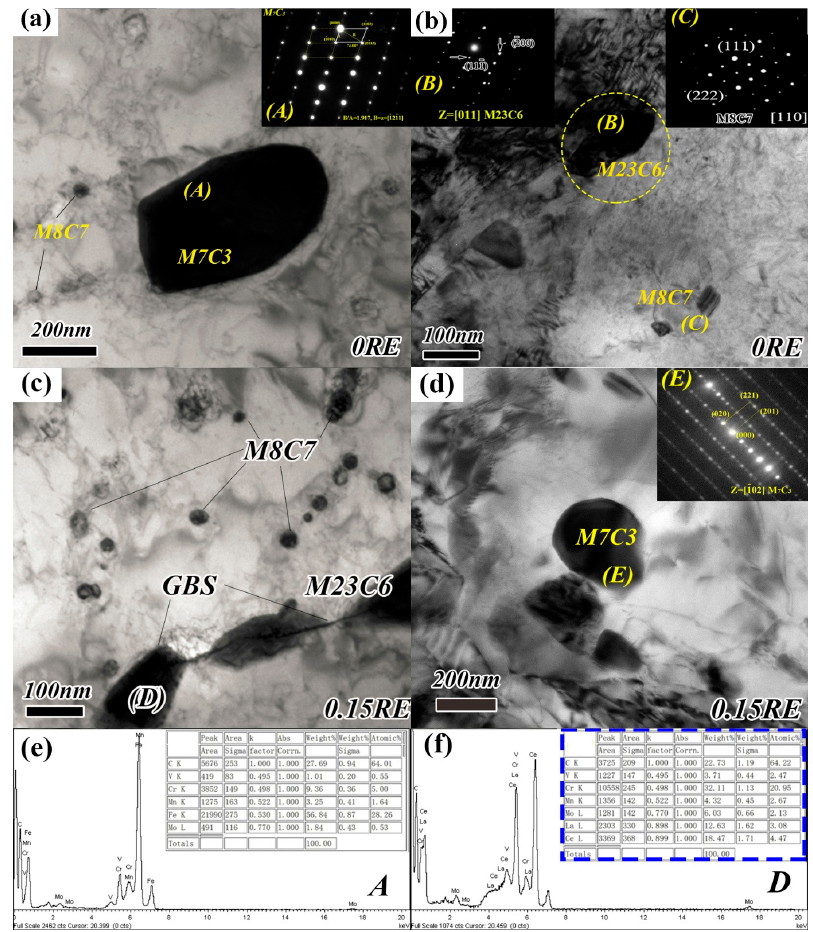
Figure 7. TEM microstructure with EDS analysis and diffraction pattern analysis of the types of carbides in the 4Cr5MoSiV1-RE die steel in 0RE and 0.15RE: ( a ) M 7 C 3 and M 8 C 7 in 0RE; ( b ) M 23 C 6 and M 8 C 7 in 0RE; ( c ) M 23 C 6 and M 8 C 7 in 0.15RE; ( d ) M 7 C 3 in 0.15RE; ( e ) the EDS analysis of M 7 C 3 at A region in ( a ) and ( f ) the EDS analysis of M 23 C 6 at D region in ( c ). (The insert in ( a ) is the selected area electron diffraction (SAED) pattern of M 7 C 3 at A region), (The insert in ( b ) is the SAED pattern of M 23 C 6 at B region), (The insert in ( b ) is the SAED pattern of M 8 C 7 at C region), and (the insert in ( d ) is the SAED pattern of M 7 C 3 at E region).